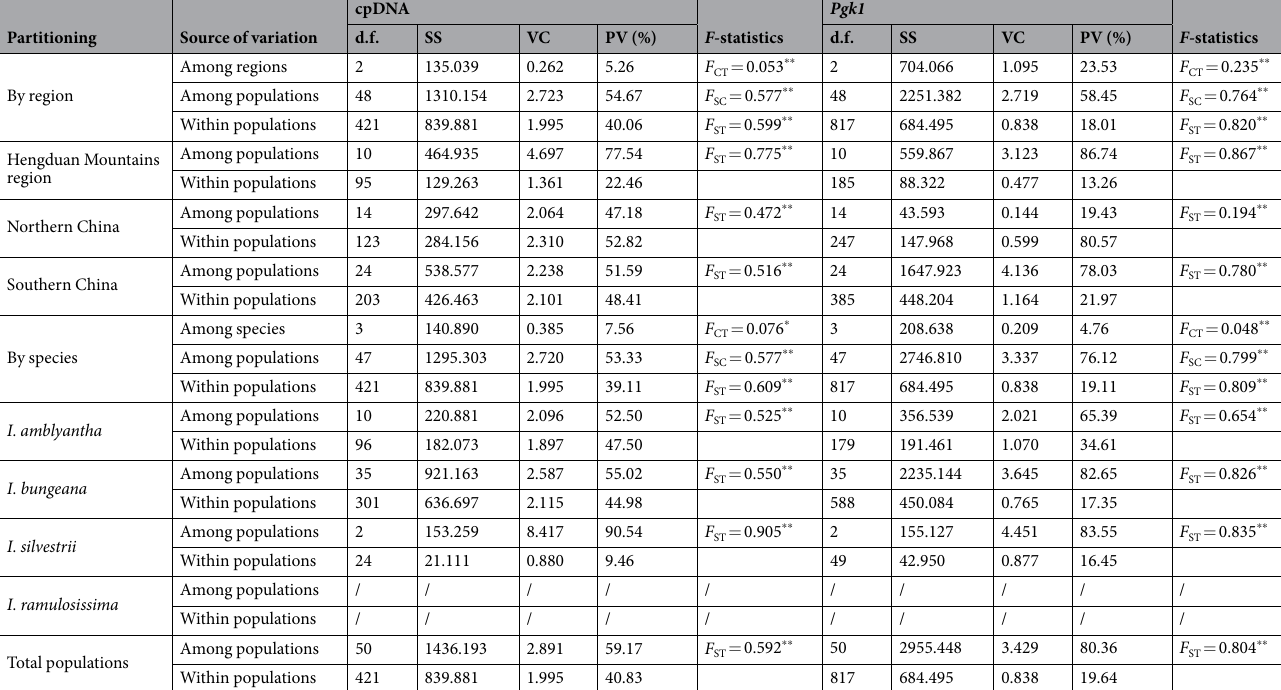
Table 3. Hierarchical analysis of molecular variance (AMOVA) of cpDNA and Pgk1 for Indigofera bungeana complex, partitioned by species and region, respectively. d.f., degree of freedom; SS, sum of squares; VC, variance of components; PV, percentage of variation * P < 0.01, ** P < 0.001.